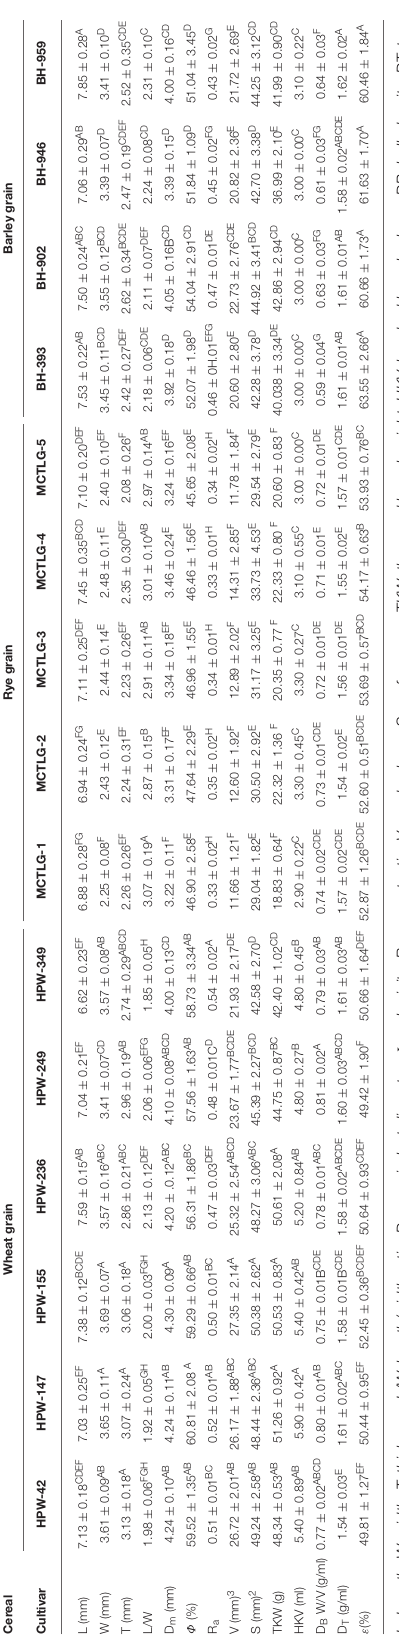
( Table 1 ) of the studied cereals, i.e., wheat, rye, and barley, were near that of the earlier reports